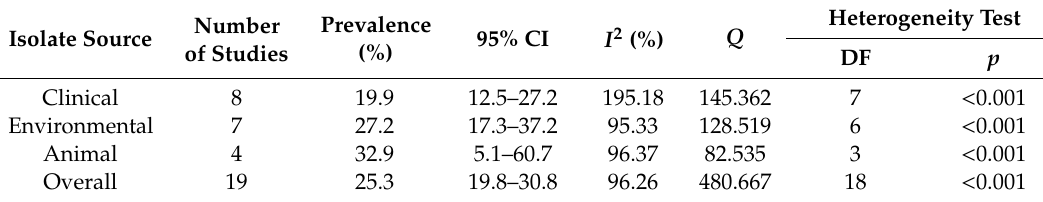
Table 4. Subgroup analysis for comparison of prevalence of VRE among isolate sources.